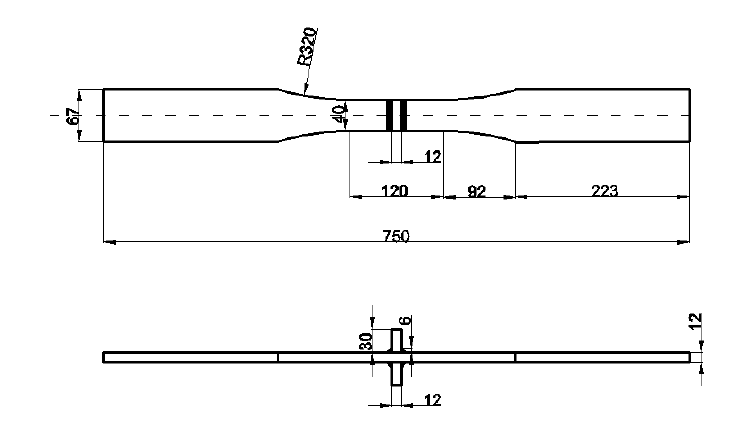
Figure 5. T-welded joint (unit: mm).